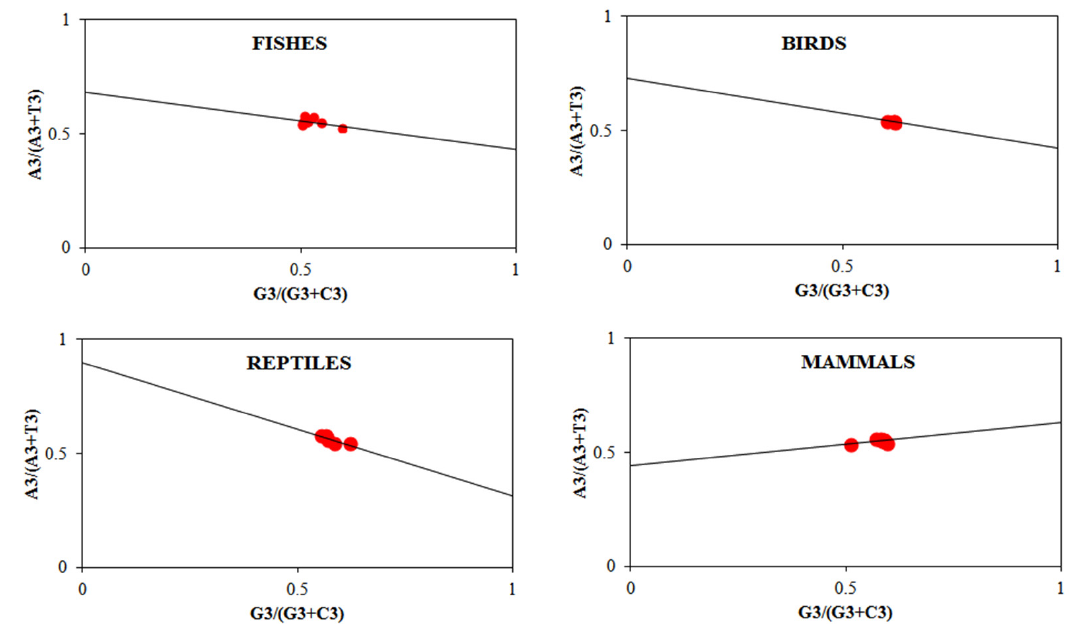
Figure 4. Parity plot analysis of Foxp2 gene among different species of fishes, reptiles, birds, and mammals showing mean values of both AT bias and GC bias were greater than 0.5, which indicates the preferential usage of purine over pyrimidine at the third-position codon. We have plotted the values of GC bias [G3/(G3 + C3)] along the X -axis and the values of AT [A3/(A3 + T3)] bias along the Y -axis.